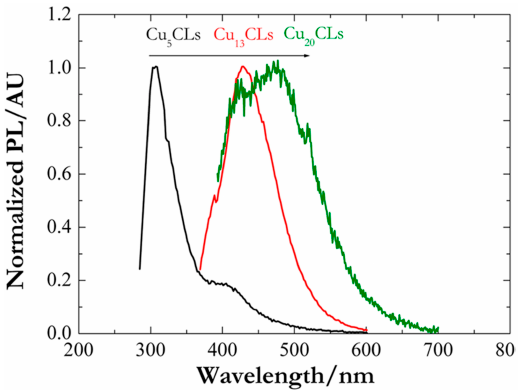
Figure 5. Emission spectra of different Cu N AQCLs, excited at 275 (nm) (Cu 5 ), 330 (nm) (Cu 13 ) and 380 (nm) (Cu 20 ), showing an increase of the emission wavelength with the clusters’ size. The figure is reprinted with permission from [23]. Copyright 2012, American Chemical Society.